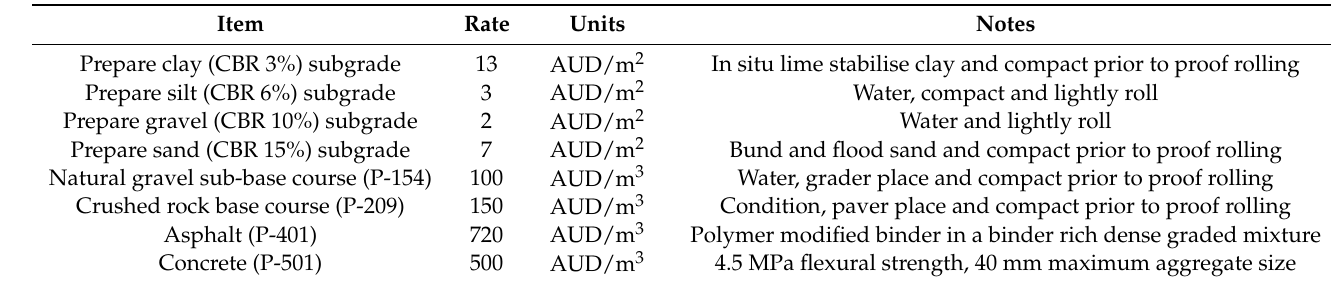
Table 5. Supply, construct and finish cost rates.